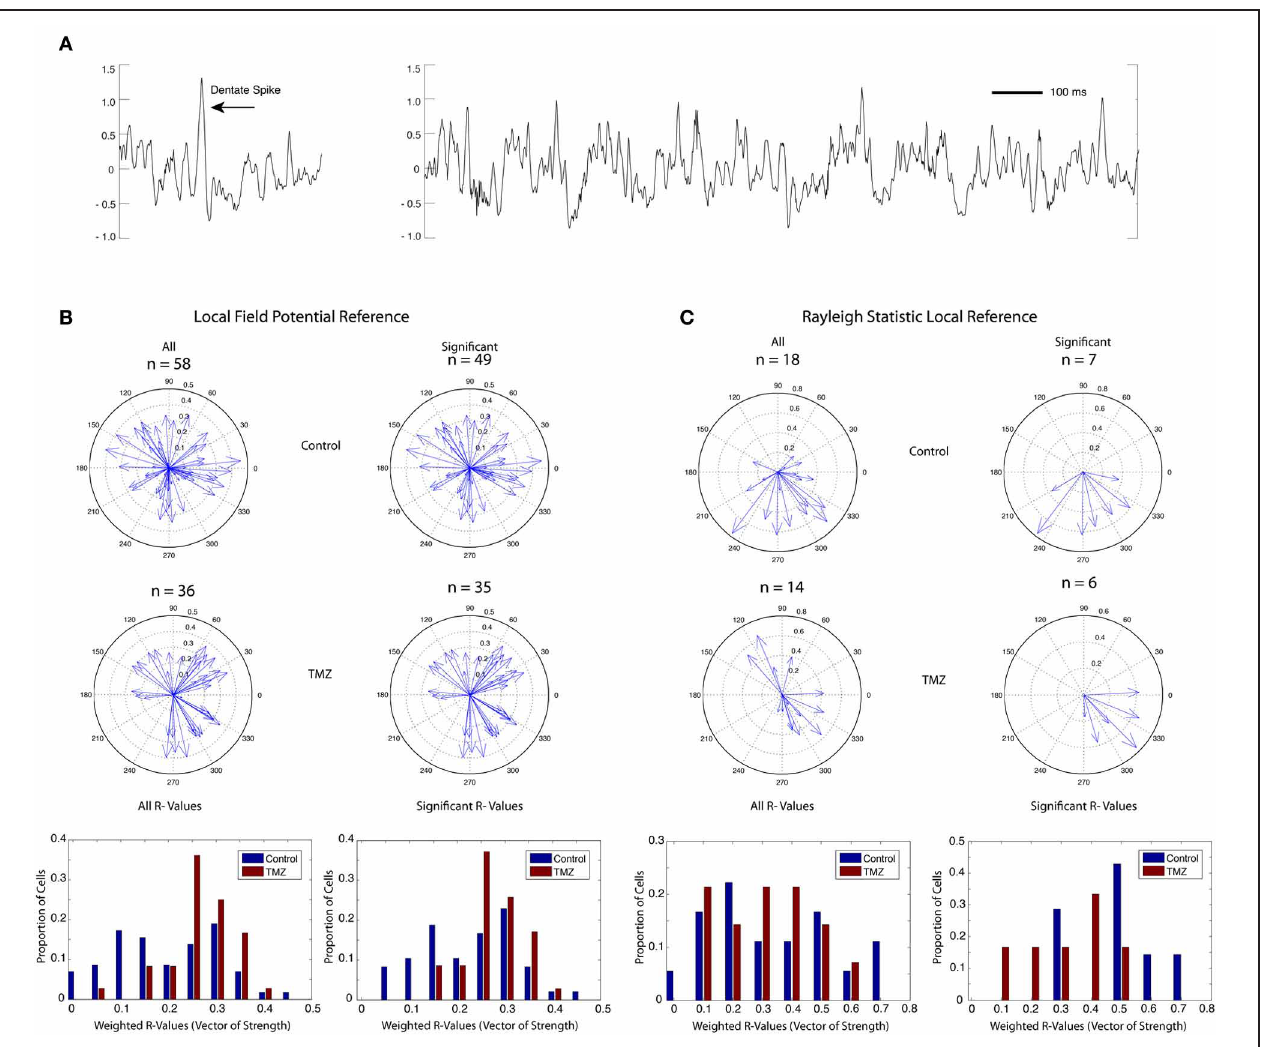
angles of all identified granule cells in TMZ-treated rats (left) and granule cells with significant phase relationships to local theta rhythm (right). Lower: histograms summarizing the distribution of vectors of strength (phase coherence magnitude) in all cells (left) and in cells with significant phase relationships only (right). Data are presented from both saline-treated (blue) and TMZ-treated (red) groups. (C) Same as (B) with phase coherence calculations restricted to spatially related firing during circular track running behavior only using a Rayleigh